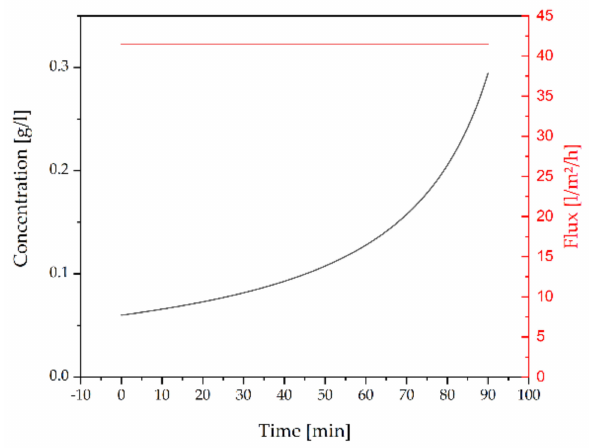
Figure 9. Overview of concentration profile, process volume and flux during the concentration step. Filtration is performed at a constant flux. This results in an exponential increase of the concentration. A 5-fold increase in concentration is achieved after 90 min.